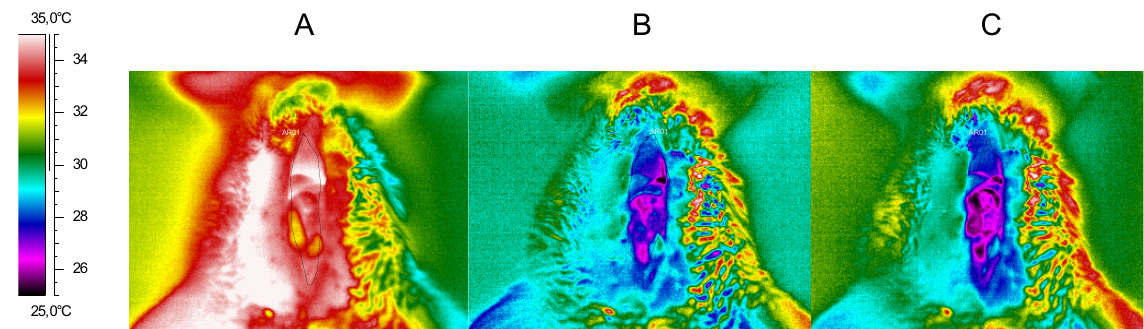
FIGURE 8 - Thermograms in group V: A – before ischemia; B – after two hours of ischemia; C – after